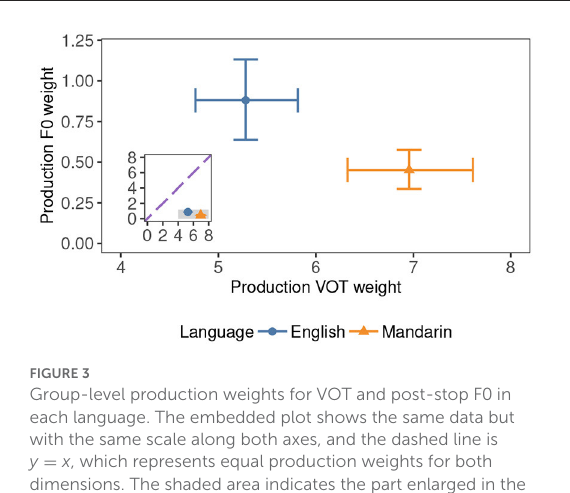
FIGURE3 Group-level production weights for VOT and post-stop F0 in each language. The embedded plot shows the same data but with the same scale along both axes, and the dashed line is y = x , which represents equal production weights for both dimensions. The shaded area indicates the part enlarged in the main plot.